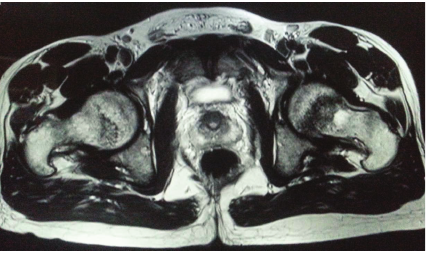
Figure 3: A T 2 weighted coronal magnetic resonance imaging (MRI) scan of pelvis with both hips showing undisplaced fracture of bilateral femur neck.